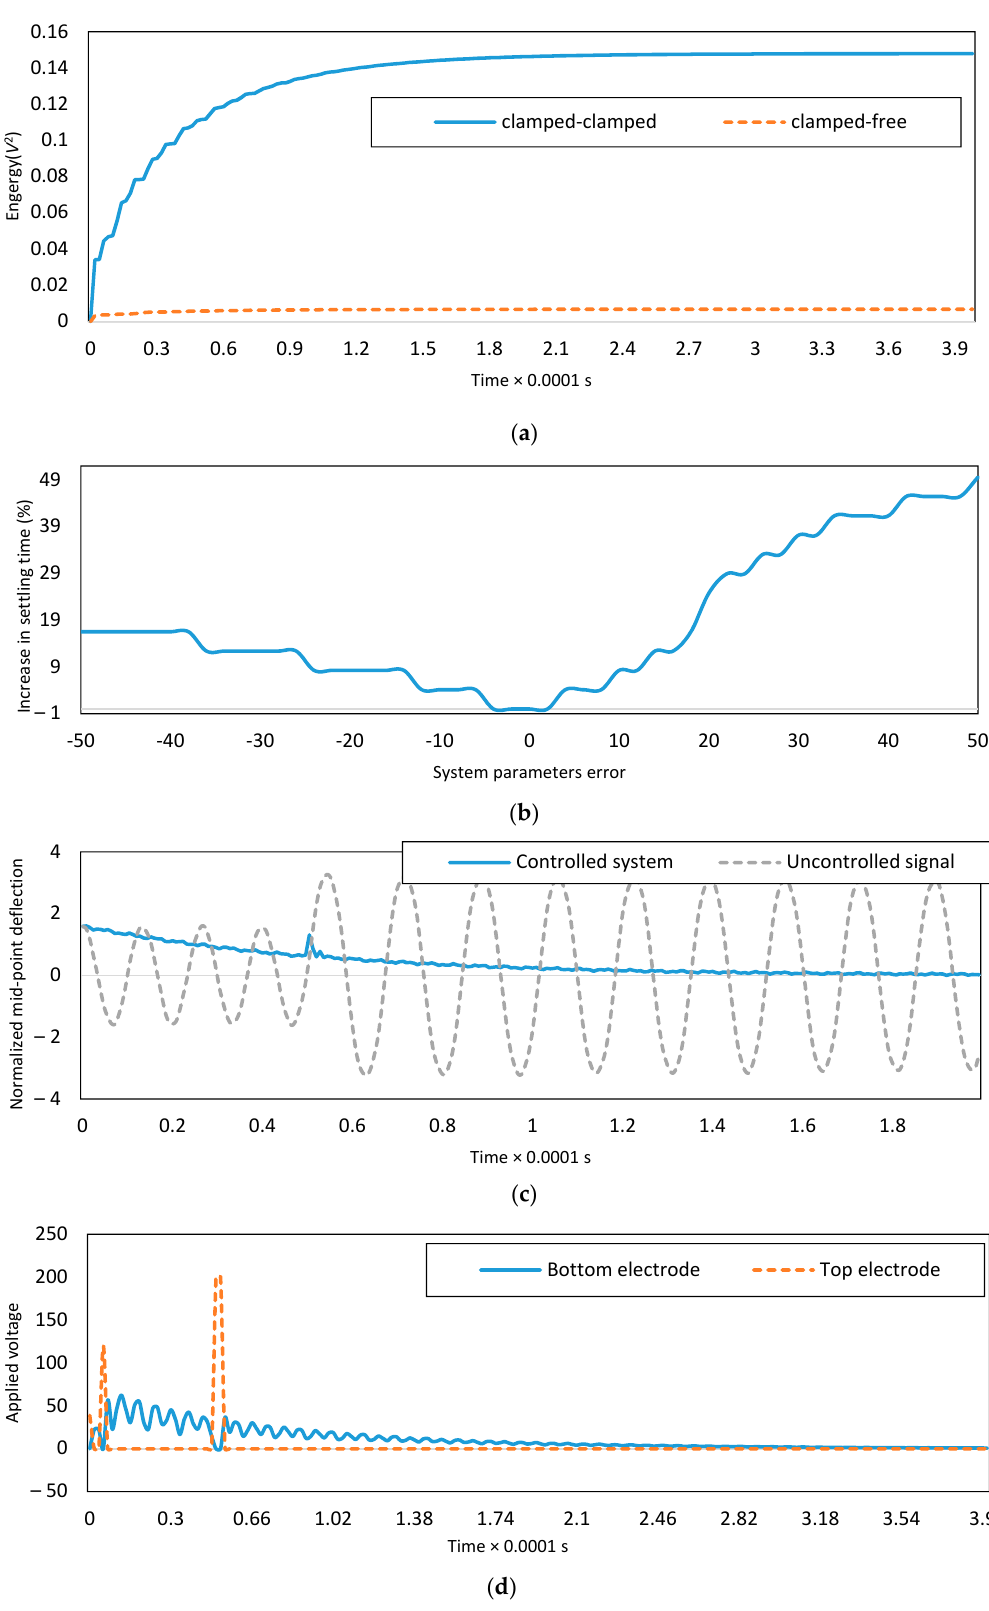
Figure 8. ( a ) Applied energy for tracking zero desired path; ( b ) increase in the settling time due to uncertainties in the system parameters; ( c ) the dynamic response of the clamped-clamped micro-switch subjected to an impulse; and ( d ) supply voltage of two electrodes under the effect of an impulse.